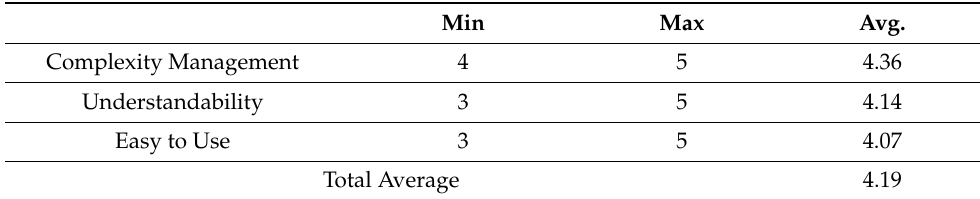
Table 6. Analysis results on perceived ease of use.